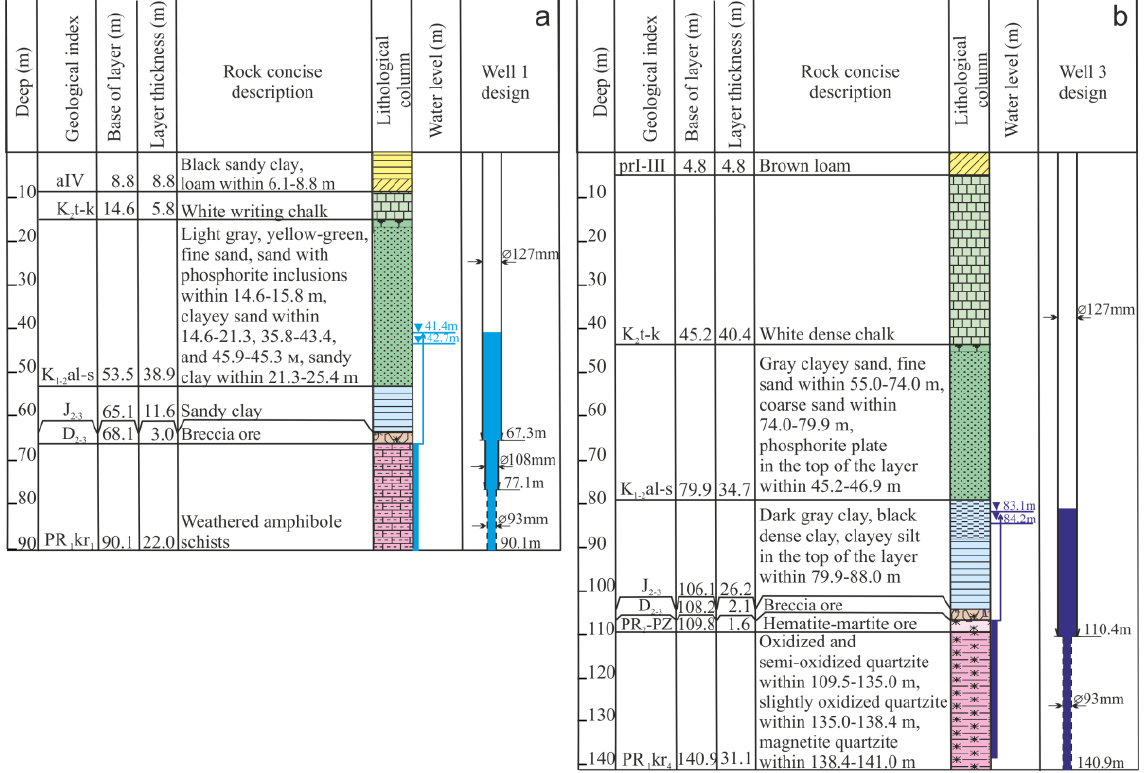
Figure 2. Geological cross section of well #1 in point I (a) and well #3 in point II (b). The Albian-Cenomanian confined aquifer of the Lower-Middle Cretaceous is predom- inantly distributed in the sedimentary strata. The Archean-Proterozoic confined aquifer